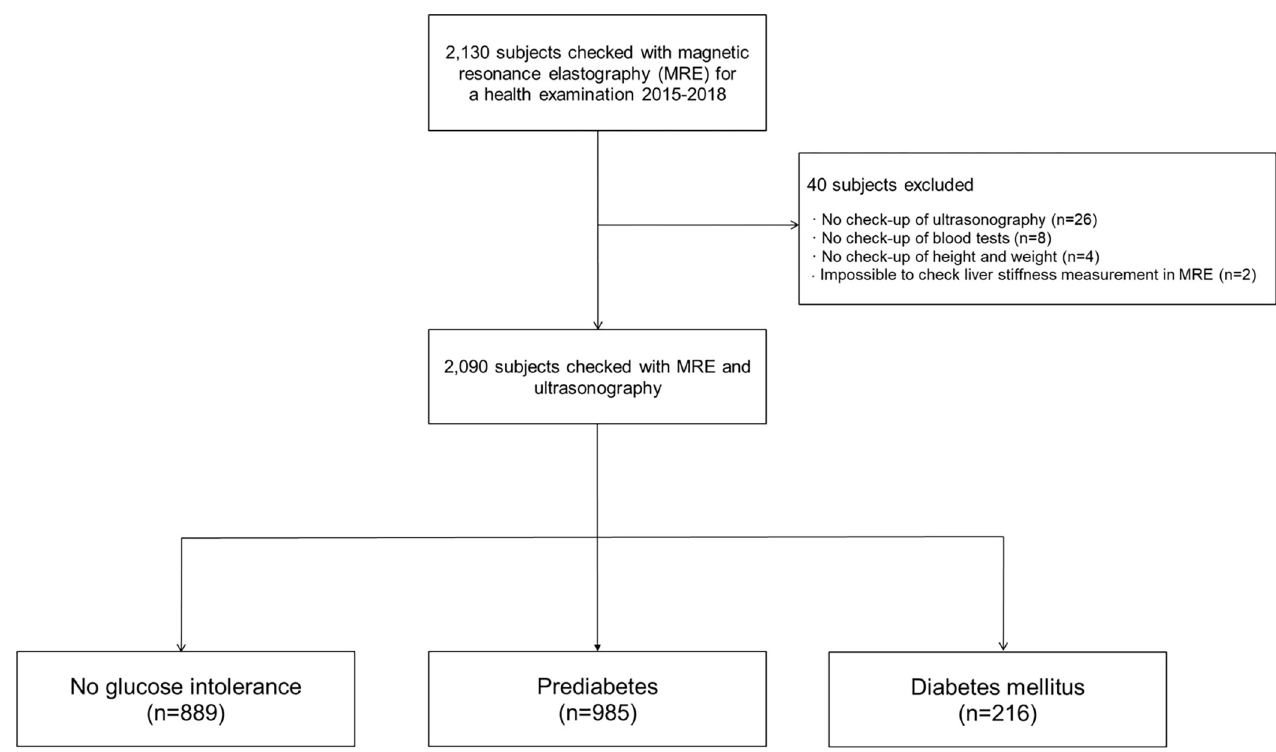
Fig 1. Flow diagram showing patient enrollment. � No glucose intolerance was defined as fasting blood sugar (FBS) levels < 100 mg/dl and hemoglobin A1c (HbA1c) < 5.7%. Prediabetes was defined as FBS levels of 100 to 125 mg/dl or hemoglobin A1c (HbA1c) levels of 5.7% to 6.4%. Diabetes mellitus was defined as FBS � 126 mg/dL or hemoglobin A1c (HbA1c) � 6.5% or treatment with anti-diabetic medication.